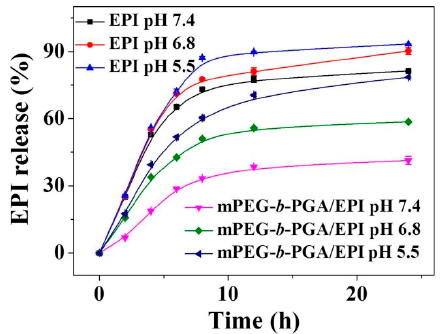
Figure 3. Time- and pH-dependent EPI release profiles of free EPI and mPEG- b -PGA/EPI in PBS of pH 7.4, 6.8, and 5.5 at 37 °C. Data were presented as mean ± SD ( n = 3). Both CLSM and FCM were employed to detect the cellular uptake and intracellular EPI release from mPEG- b -PGA/EPI. HepG2 cells were cultivated with free EPI or mPEG- b -PGA/EPI at an EPI